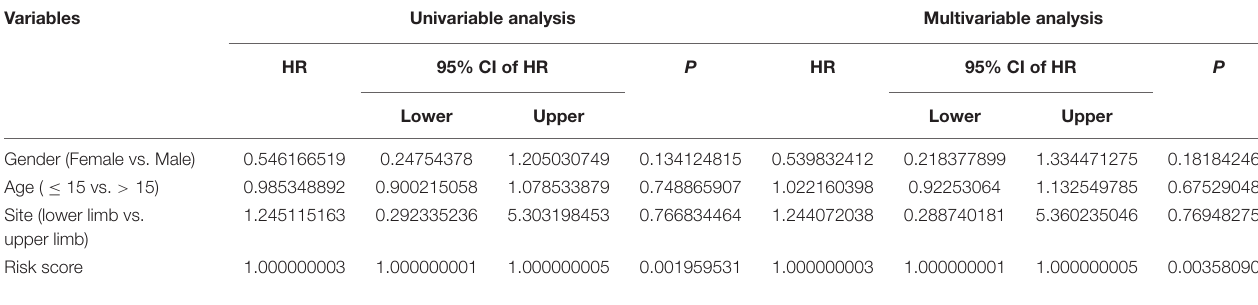
TABLE 3 | Univariable and multivariable analysis of the six-MRG signature and clinical factors in the TCGA osteosarcoma cohort.